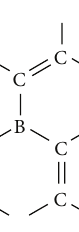
Figure 3: B-C sp 2 bond in the BC 6 structure of ta-C:B.